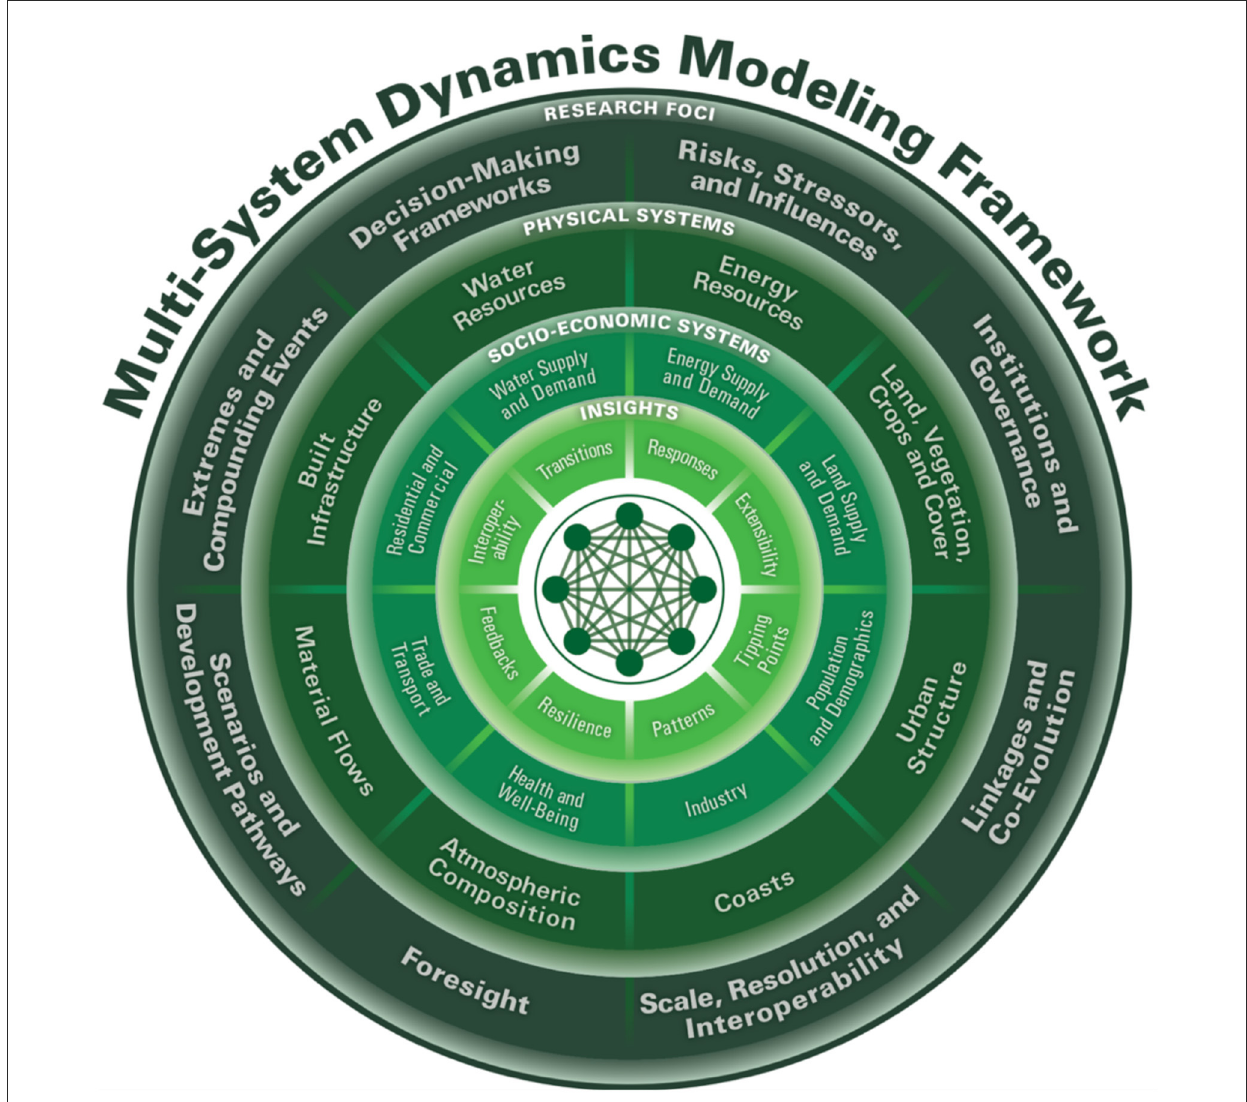
FIGURE1 Schematic representation of the multi-sector dynamic framework that recognizes the co-evolving nature of socio-economic and physical systems. These systems must be considered as connected to gain insights into the various landscapes of vulnerabilities, compounding risks, and environmental instabilities and